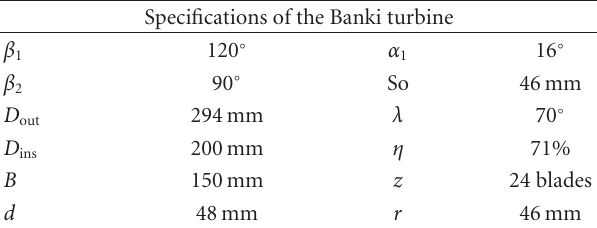
Table 1: Design parameters for the cross-flow turbine used as test